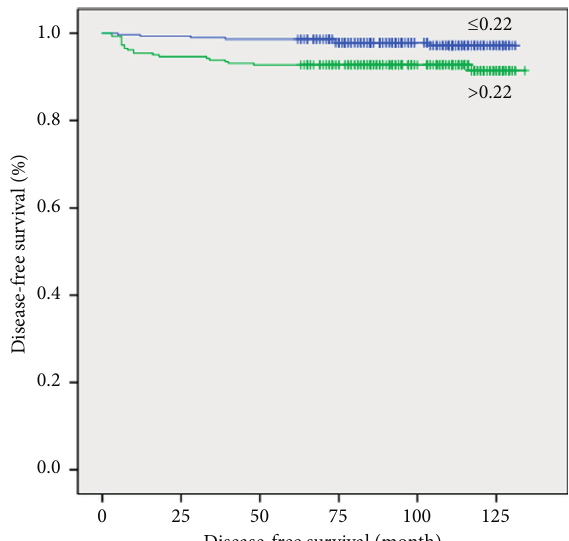
Figure 3: Disease-free survival curves according to post-RAI serum Tg level after propensity score matching (cut-off, 10ng/mL; p < 0 .